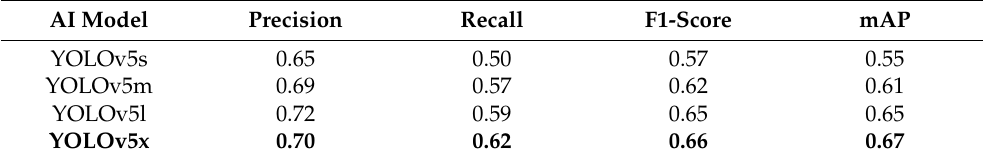
Table 1. The evaluation performance of all versions of the YOLO detectors as an average over three trails.